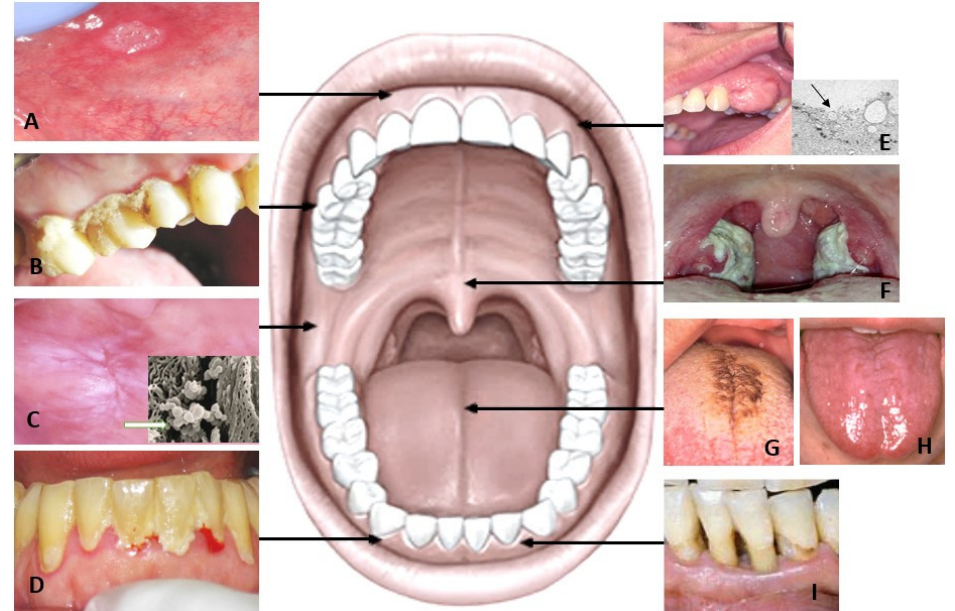
Figure 2. Aphthous ulcer presents erythematous halo surrounding round yellowish ulcer ( A ). Caries ( B ) is one of the most common individual illnesses. Leukoplakia of the buccal mucosa ( C ) can colonize more microorganisms than the healthy mucosa (studied with SEM). Dental plaque and bleeding of the gingiva ( D ) are sources of different metabolites in the whole mouth saliva. Oral tumors ( E ) and their small vesicles (arrow) produce metabolites, which can be used in diagnostics. Pharyngitis in tonsils ( F ) must also be remembered in saliva studies. Changes of the dorsal tongue surface, including hairy tongue ( G ) and atrophic tongue without hairs of filiform papillae ( H ) affect the biofilm of the oral cavity. Parodontitis ( I ) causes deep pockets around the teeth with many anaerobic bacteria altering the oral